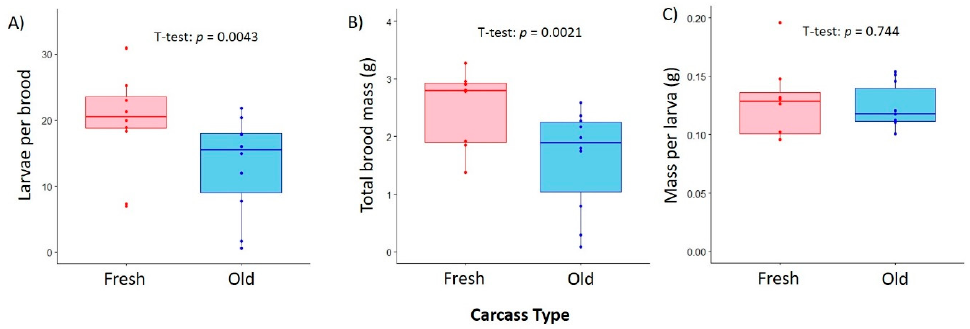
Figure 1. Box-and-whisker plots depicting the effect of carcass type on ( A ) total number of larvae sired by a mating pair of Nicrophorus vespilloides , ( B ) total brood mass, and ( C ) average mass per individual larva. Data points refer to individual samples, and boxplots denote median values and upper- and lower-quartiles.